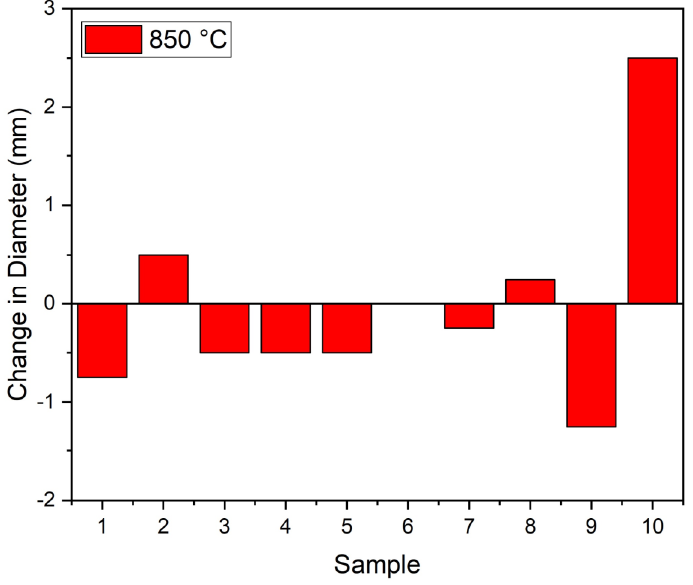
Figure 8. Changes in diameter of pellets for reduction experiments using H 2 gas at 850 °C.